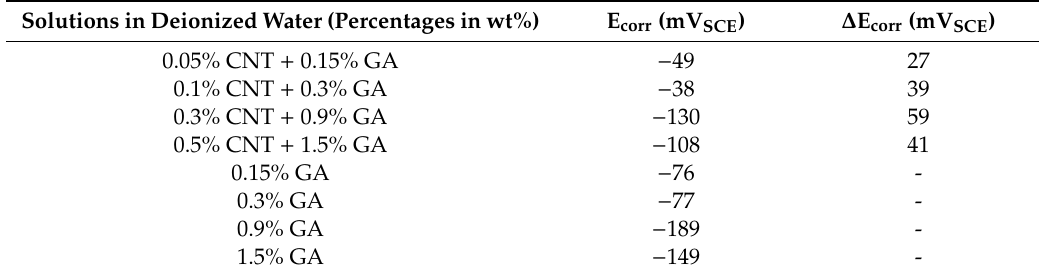
Corrosion potential values for 316L stainless steel tested in di ff erent solutions at room